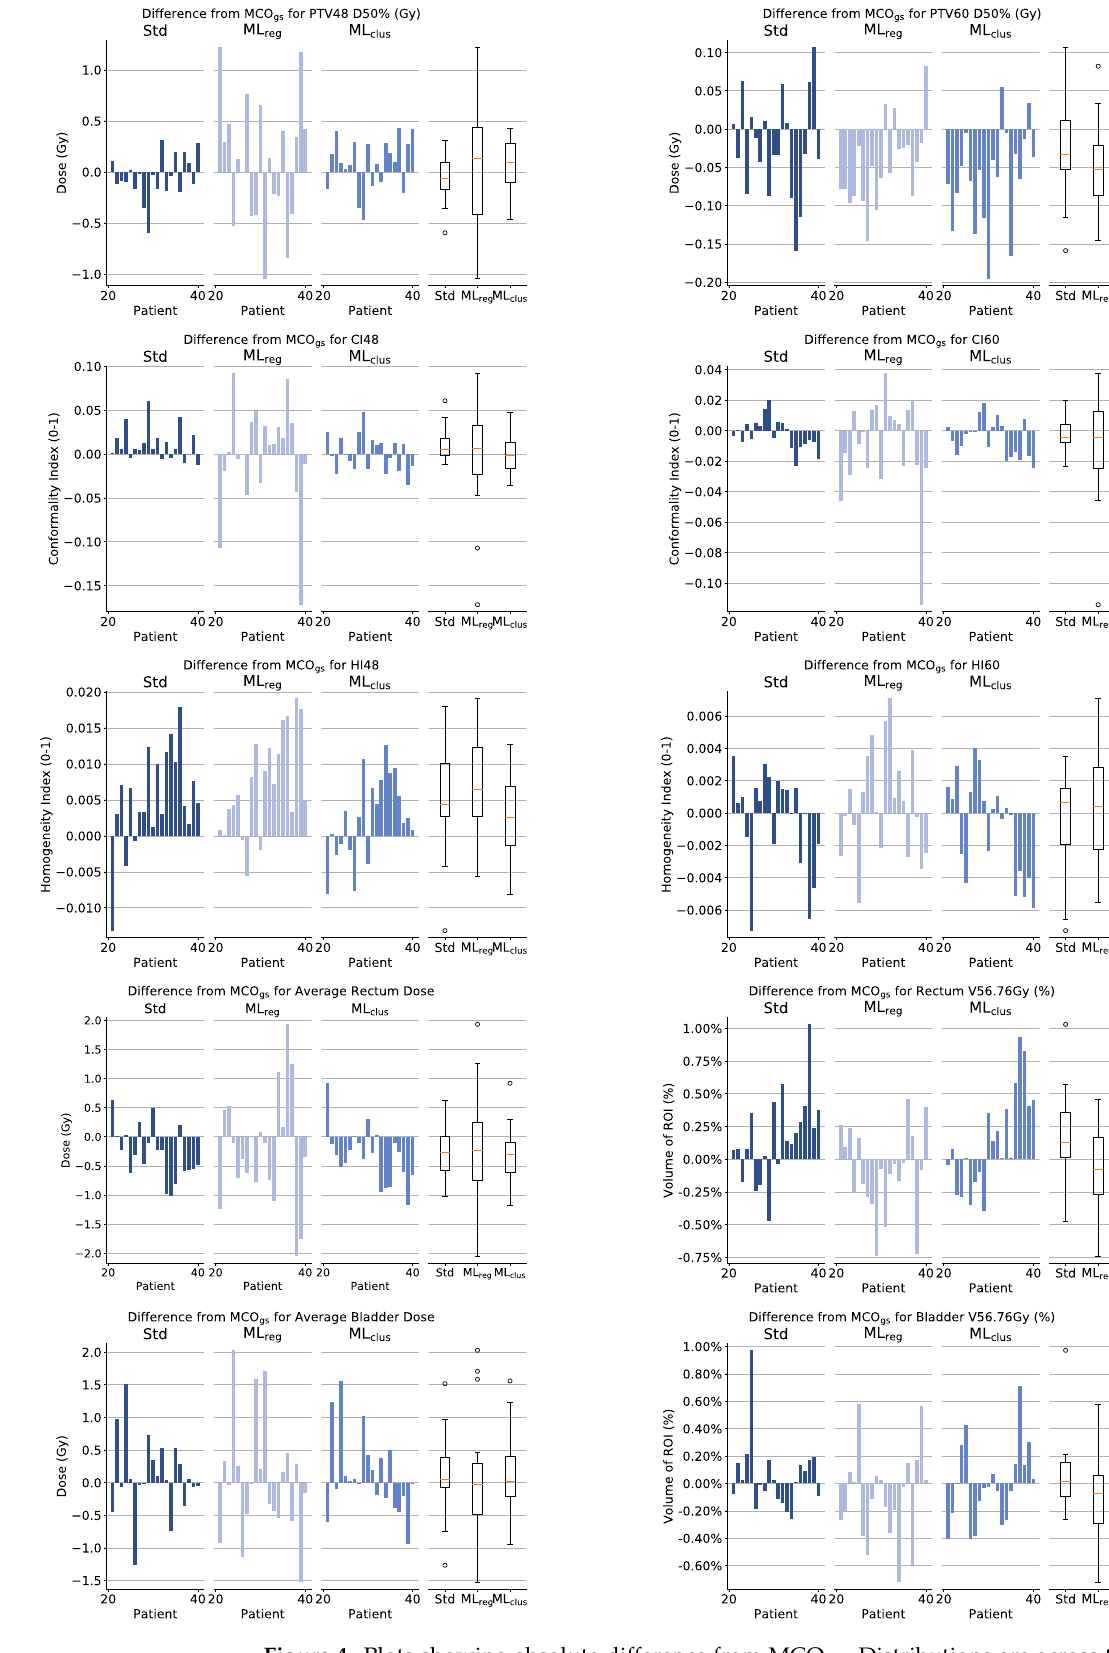
Figure 4. Plots showing absolute difference from MCO gs . Distributions are across the validation dataset of key dose related metrics for each of the three calibration